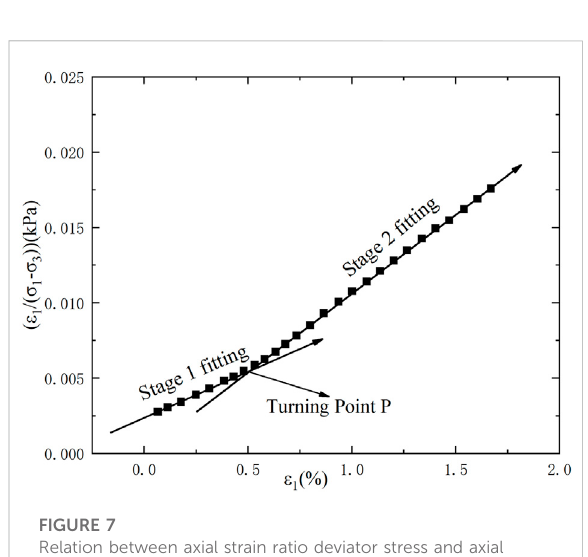
FIGURE 7 Relation between axial strain ratio deviator stress and axial